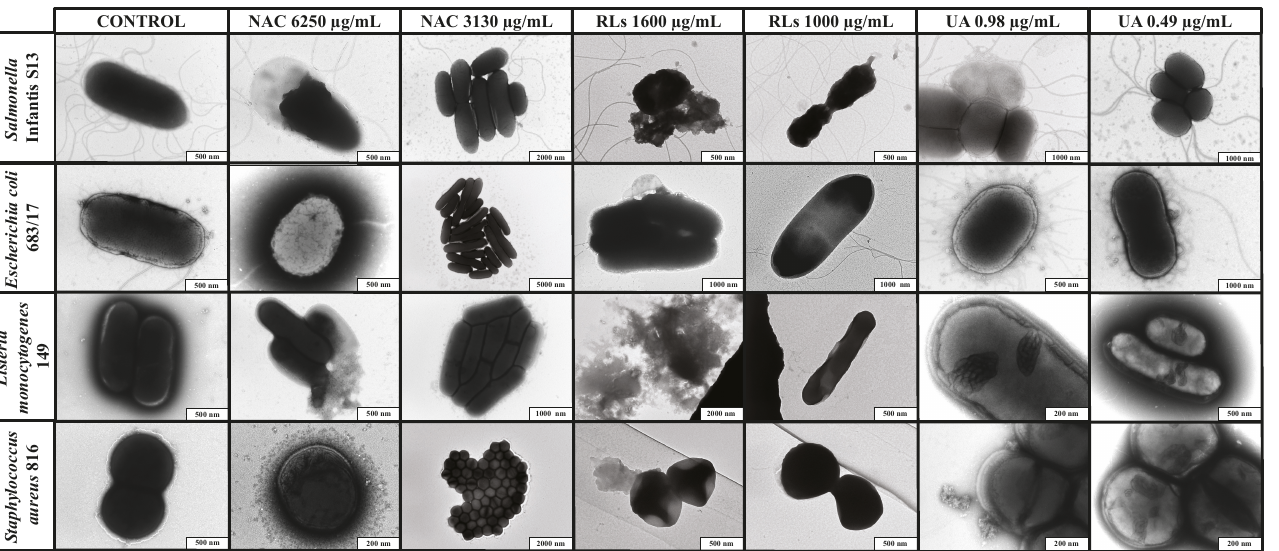
Figure 1. Interactions of tested substances N -Acetyl- L -cysteine (NAC), rhamnolipids (RLs), and usnic acid (UA) with planktonic cells of Salmonella Infantis S13, Escherichia coli 683/17, Listeria monocytogenes 149, and Staphylococcus aureus 816 visualized by TEM after 8 h of